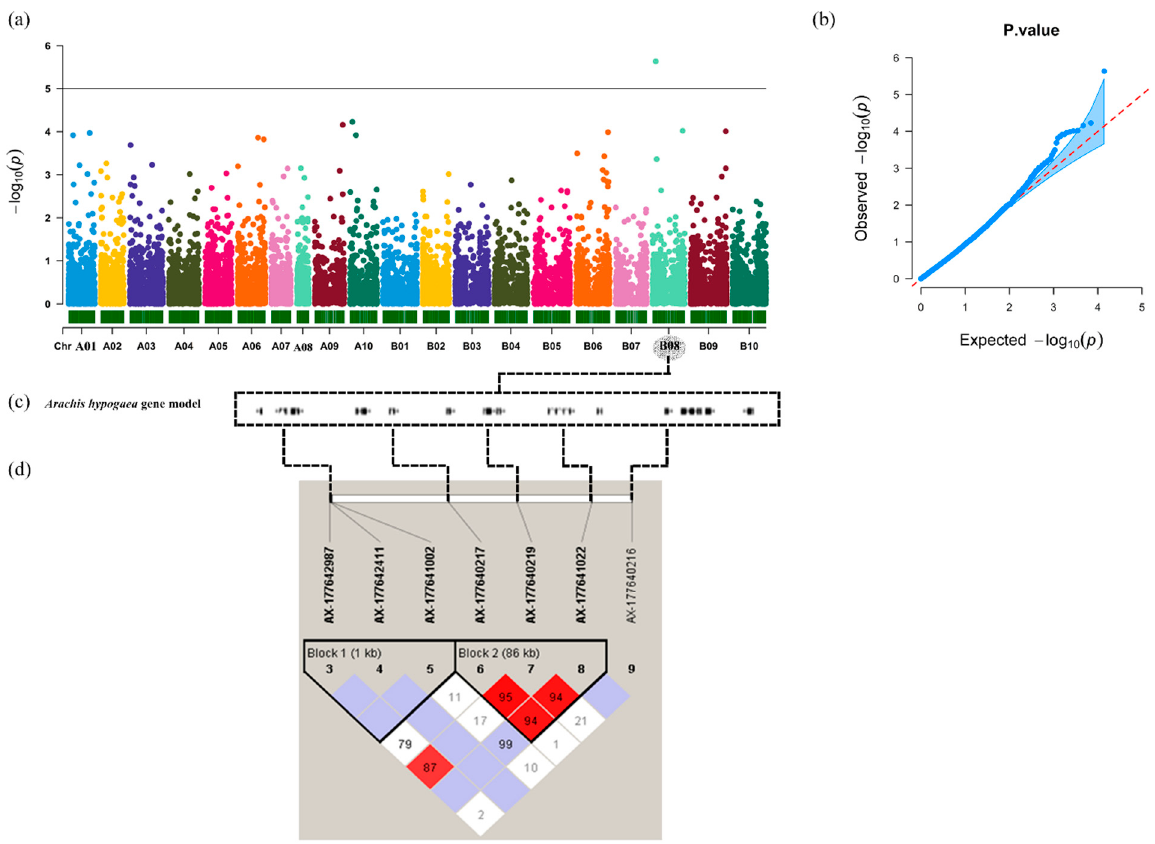
Figure 5. ( a ) Manhattan plot of a genome-wide association analysis by GAPIT; ( b ) Q-Q (quantile-quantile) plot; ( c ) Genes located at the association regions based on the Arachis hypogaea Tifrunner 1.0 reference genome; ( d ) Linkage disequilibrium (LD) plot generated using Haploview, D’ values that correspond to SNP pairs are shown within the respective squares. Higher D’ values are indicated with a brighter red color. Table 1. Significant markers associated with seed aspect ratio of peanut identified using GAPIT analysis.